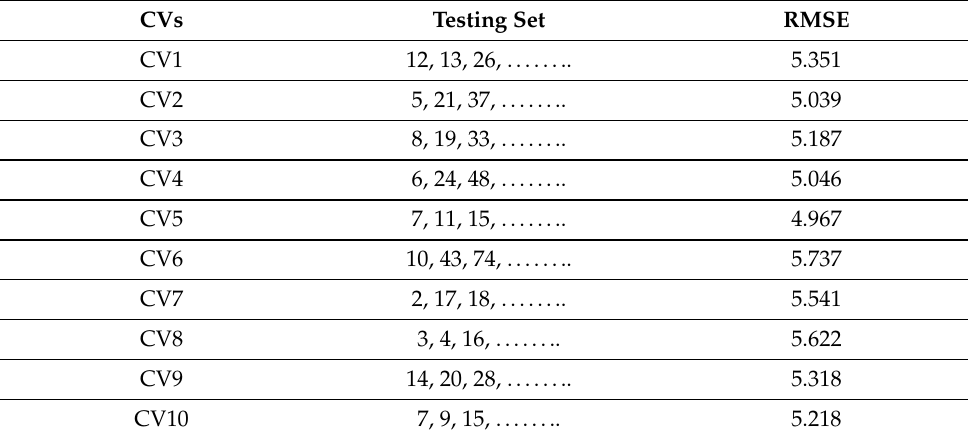
Table A4. Tabulation of observed RMSE values across 10 cross-validation folds.